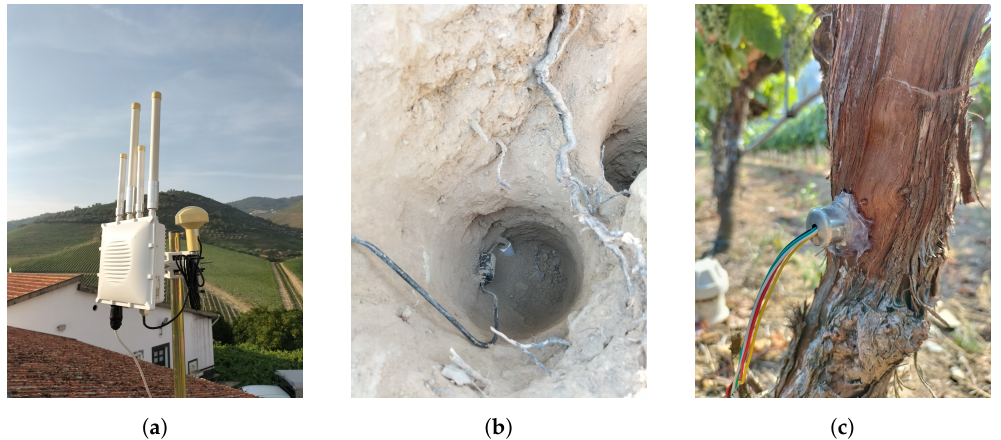
Figure 6. Placement of the ( a ) LoRaWAN gateway, ( b ) soil sensors and ( c ) vine sensors (FloraPulse sensor on a vine trunk) at Quinta dos Aciprestes.